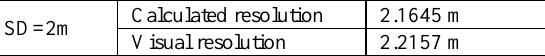
Table 4. The estimated spatial resolution for GF-1 panchromatic sensor (6) MTF